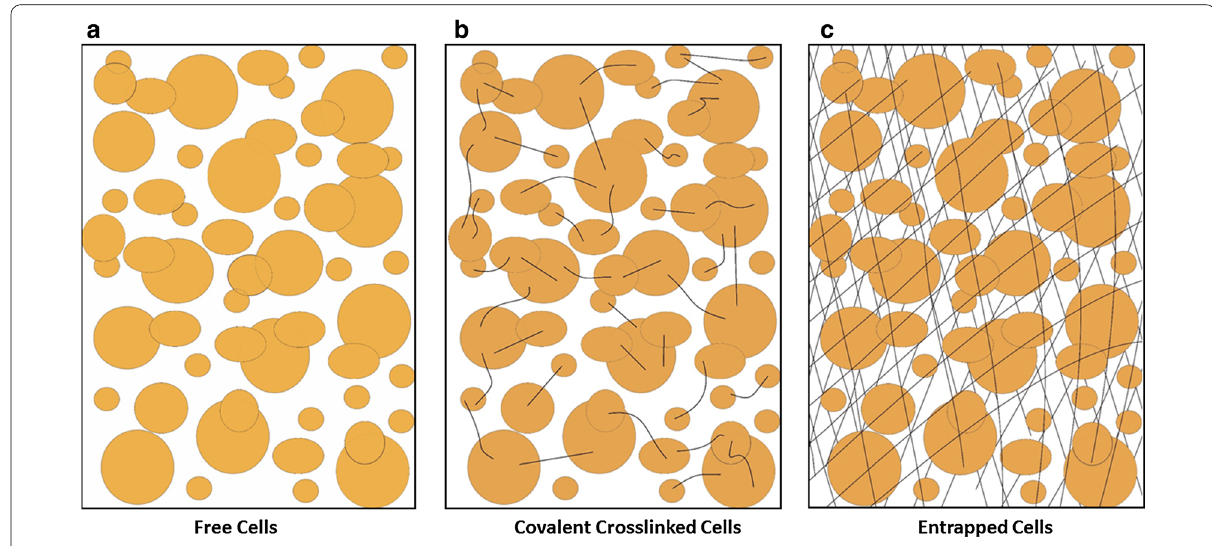
Fig. 2 Schematic representation of cell immobilized techniques: a Free cells, b Covalent crosslinked, c